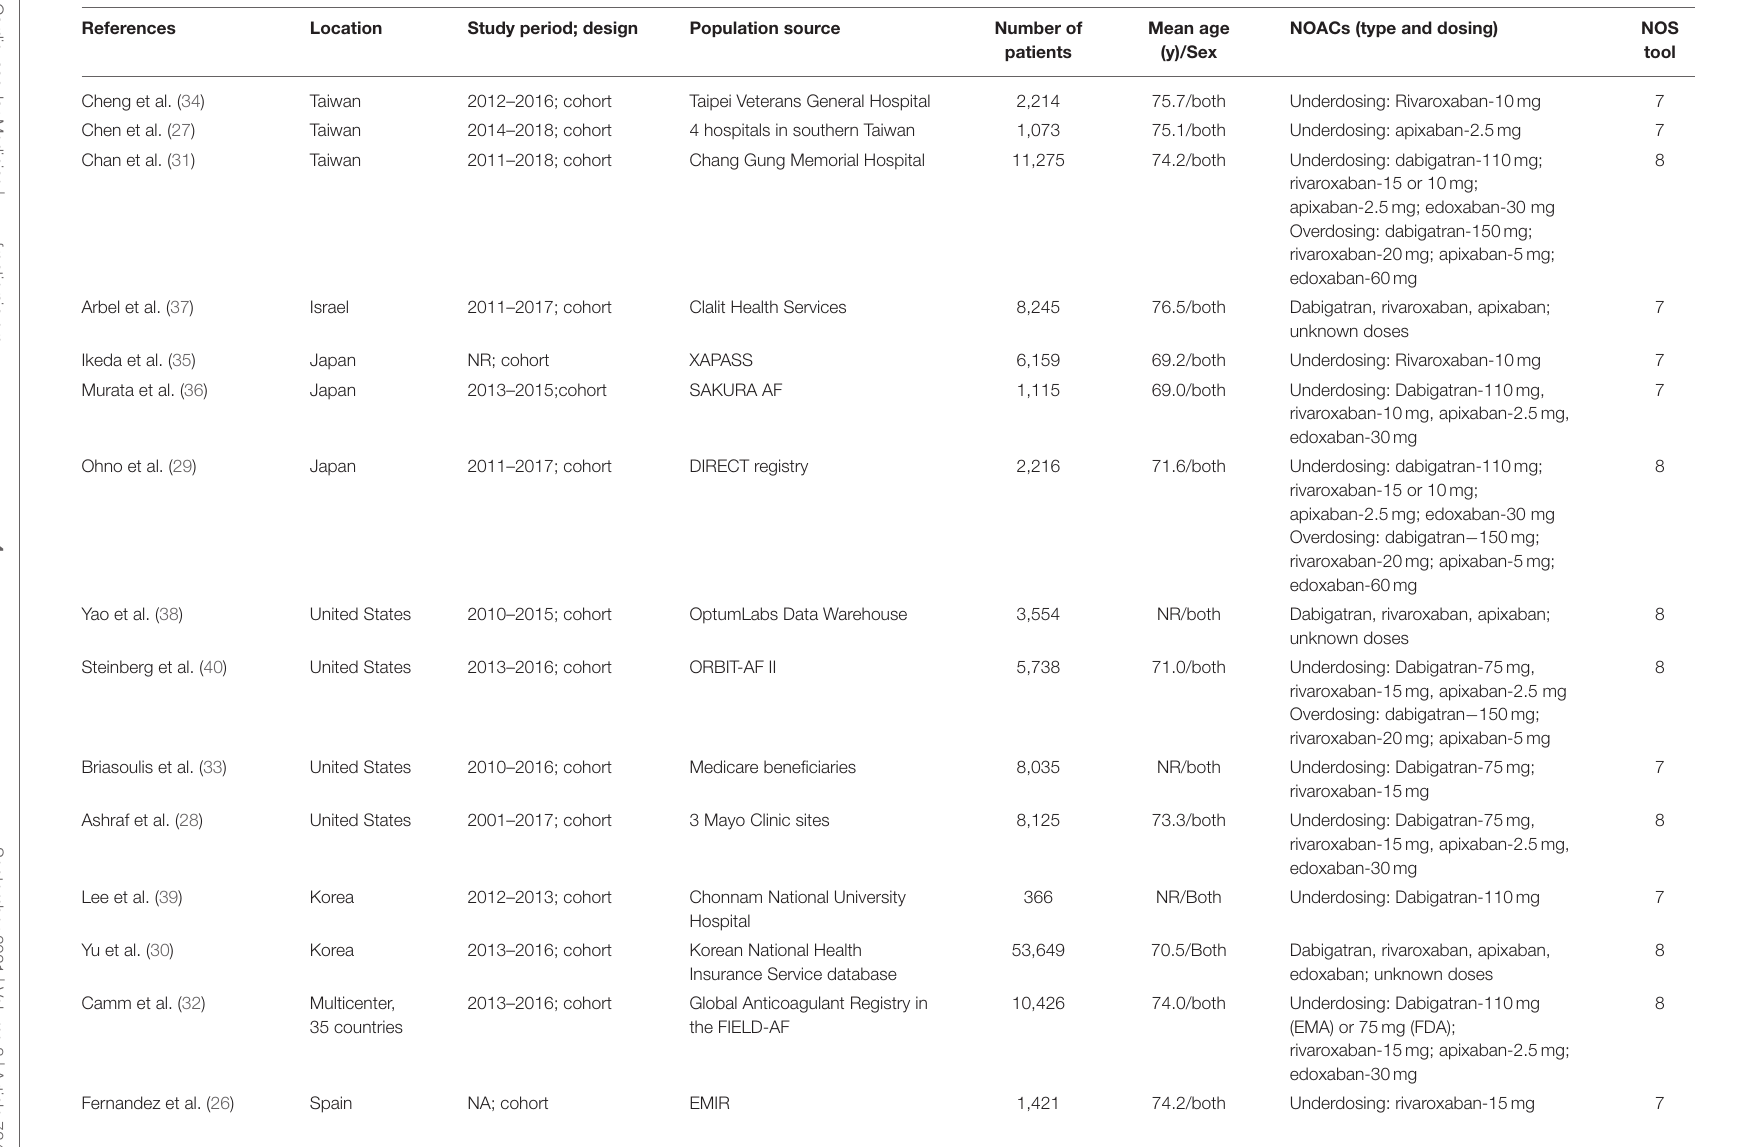
TABLE 1 | Baseline characteristics of the included